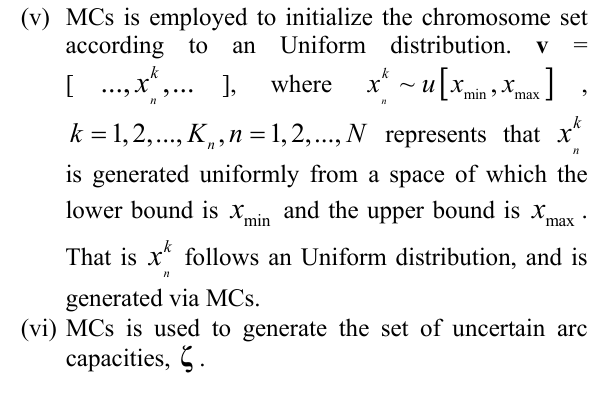
Table 1. The optimal solutions and the objective function values versus different γ and T Strategy